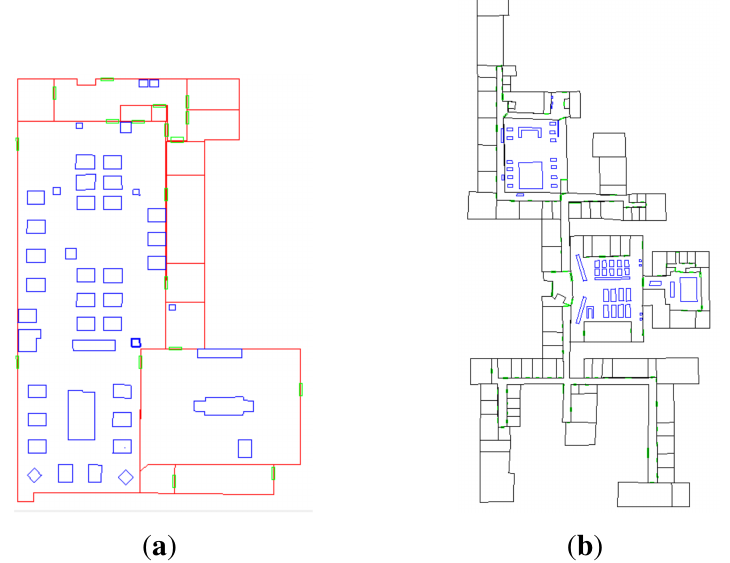
Figure 13. The floor plans of two buildings. ( a ) The floor of the conventional neonatal intensive care unit (CNICU) at the hospital; ( b ) ground floor of the Architecture Faculty